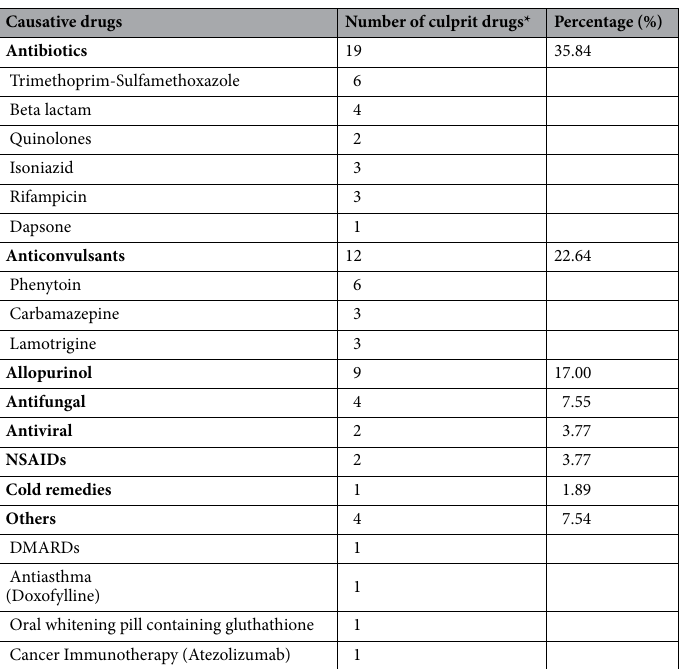
Table 3. Causative drugs of Stevens–Johnson syndrome or toxic epidermal necrolysis. NSAIDs nonsteroidal anti-inflammatory drugs; DMARDs disease-modifying antirheumatic drugs. *Include both single possible culprit drug and more than one possible culprit